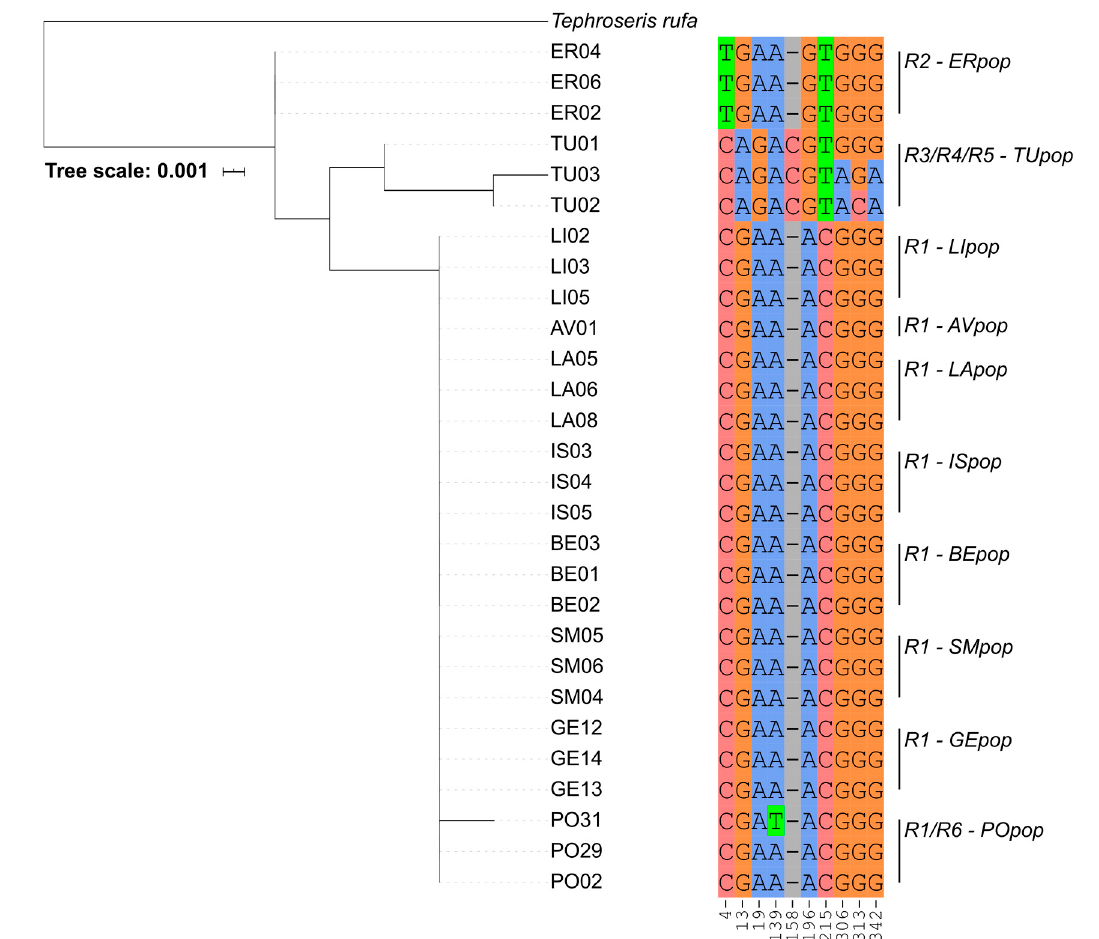
Figure 2. Ribotypes partial alignment of all the 28 analyzed samples: Each nucleotide corresponds to a specific position into the global alignment reported at the column base.